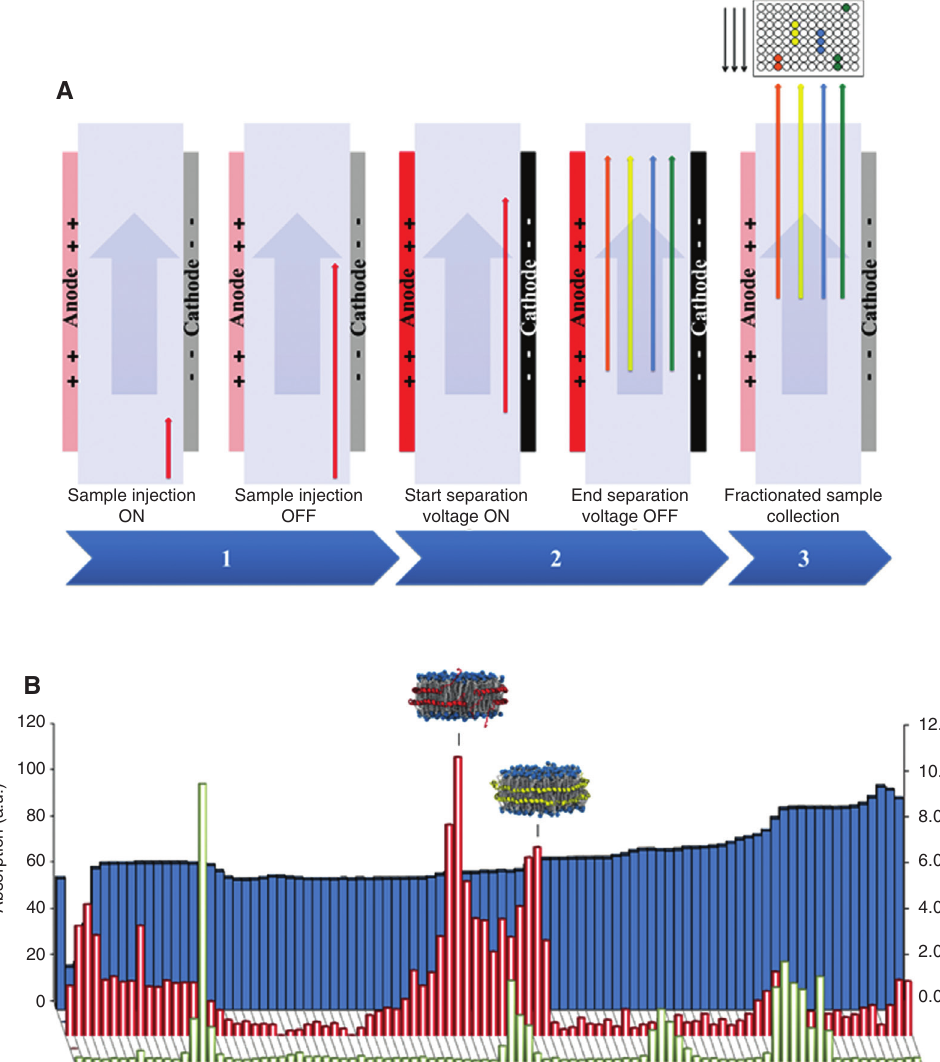
Figure 2 Free flow IZE for the separation of